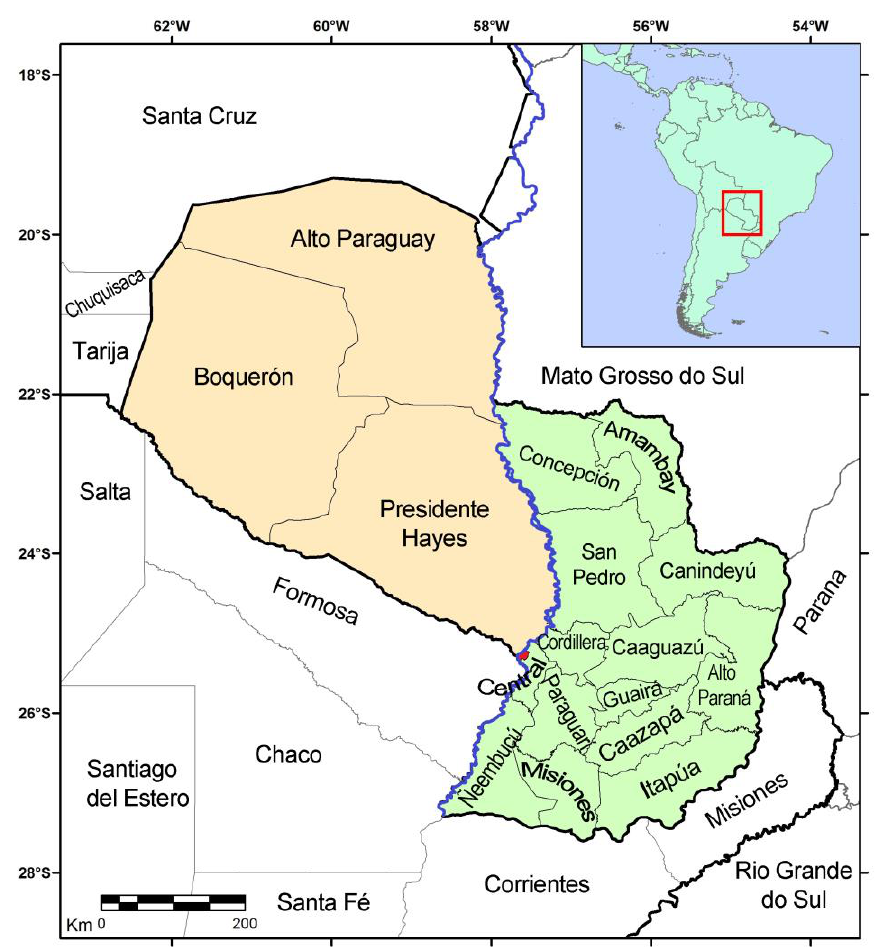
Figure 1. Administrative divisions of Paraguay, showing the two regions known as “Occidental Region” or Chaco (light brown) and “Oriental Region” (light green), divided by the Paraguay River (highlighted in blue in the map).